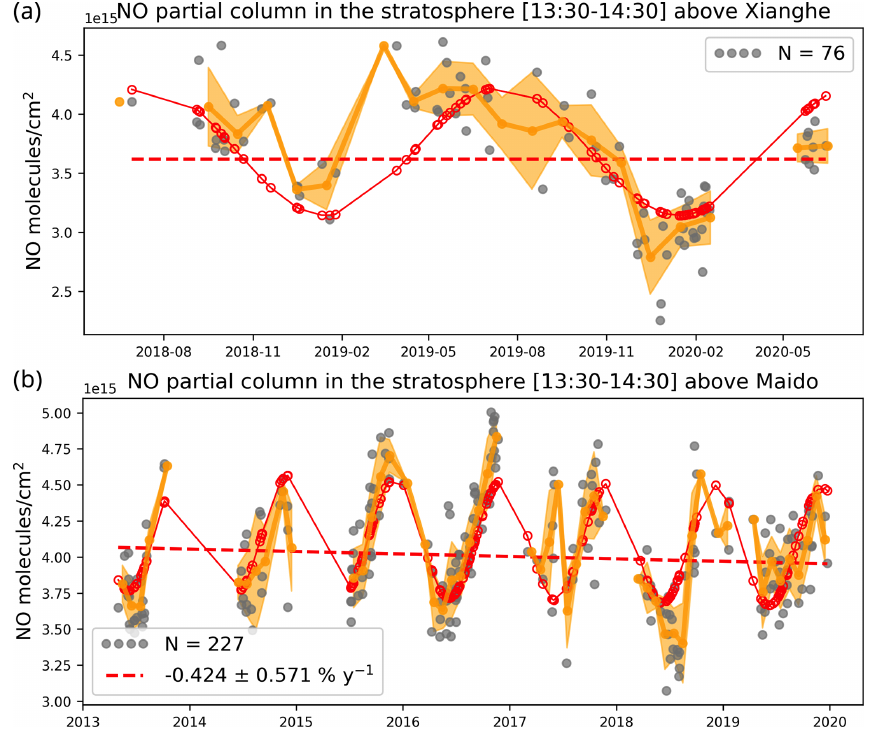
Figure 8. The time series of the FTIR-NO-retrieved stratospheric partial column daily means (gray dots) and monthly means and SDs (yellow dots and shadow) at Xianghe (a) and Maïdo (b) for only the measurements between 13:30 and 14:30LT. N is the measurement days. The dashed red line is the A 0 + A 1 t in Eq. (3), the red dots and the red solid line are the fittings with the seasonal